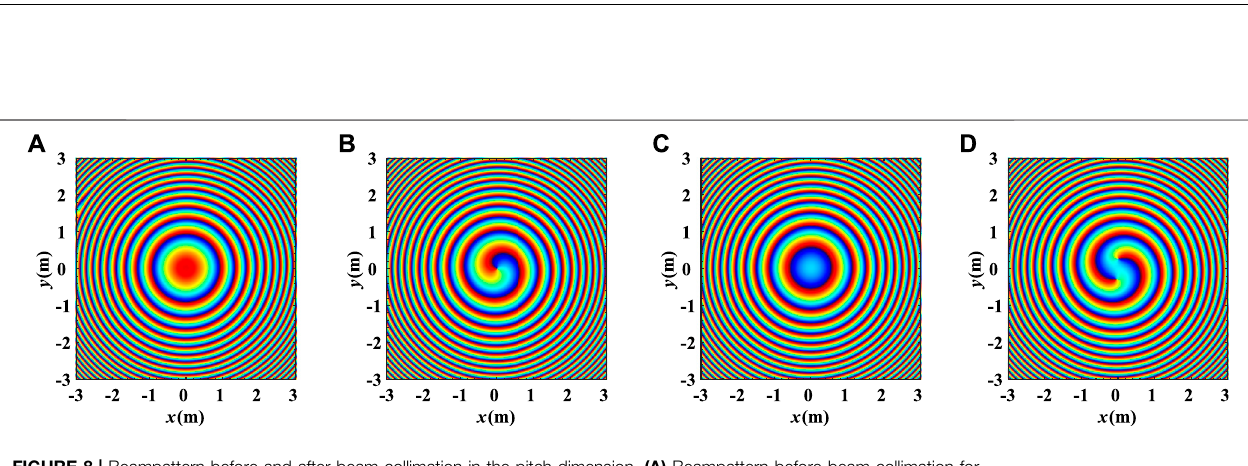
, θ , ϕ ) (cid:1) ( 1 . 25 m , 0 ° , 0 ° ) ; (C) beampattern before t t t